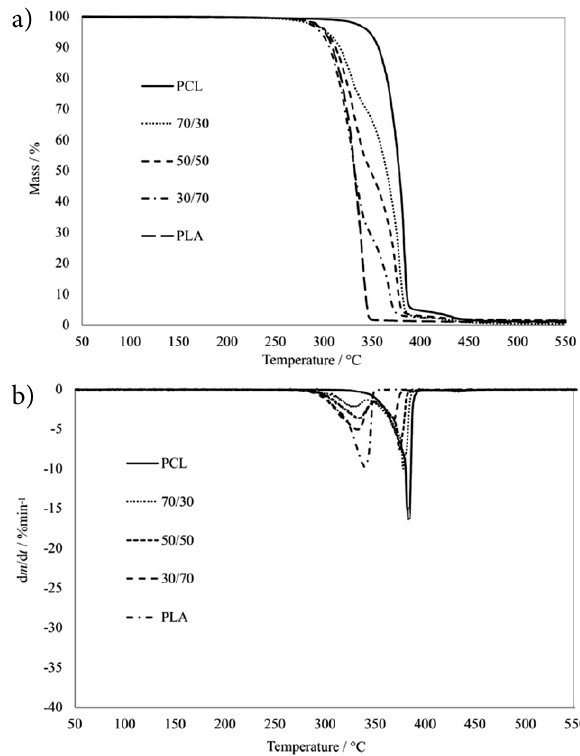
Fig. 1. TG (a) and DTG (b) curves of the thermal degradation of the PCL/PLA blends at the heating rate of 2.5 °C min −1 .